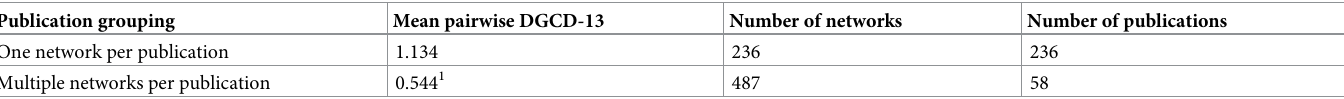
Table 4. Mean pairwise directed graphlet correlation distance-13 (DGCD-13) of bipartite species interaction networks from the same publication